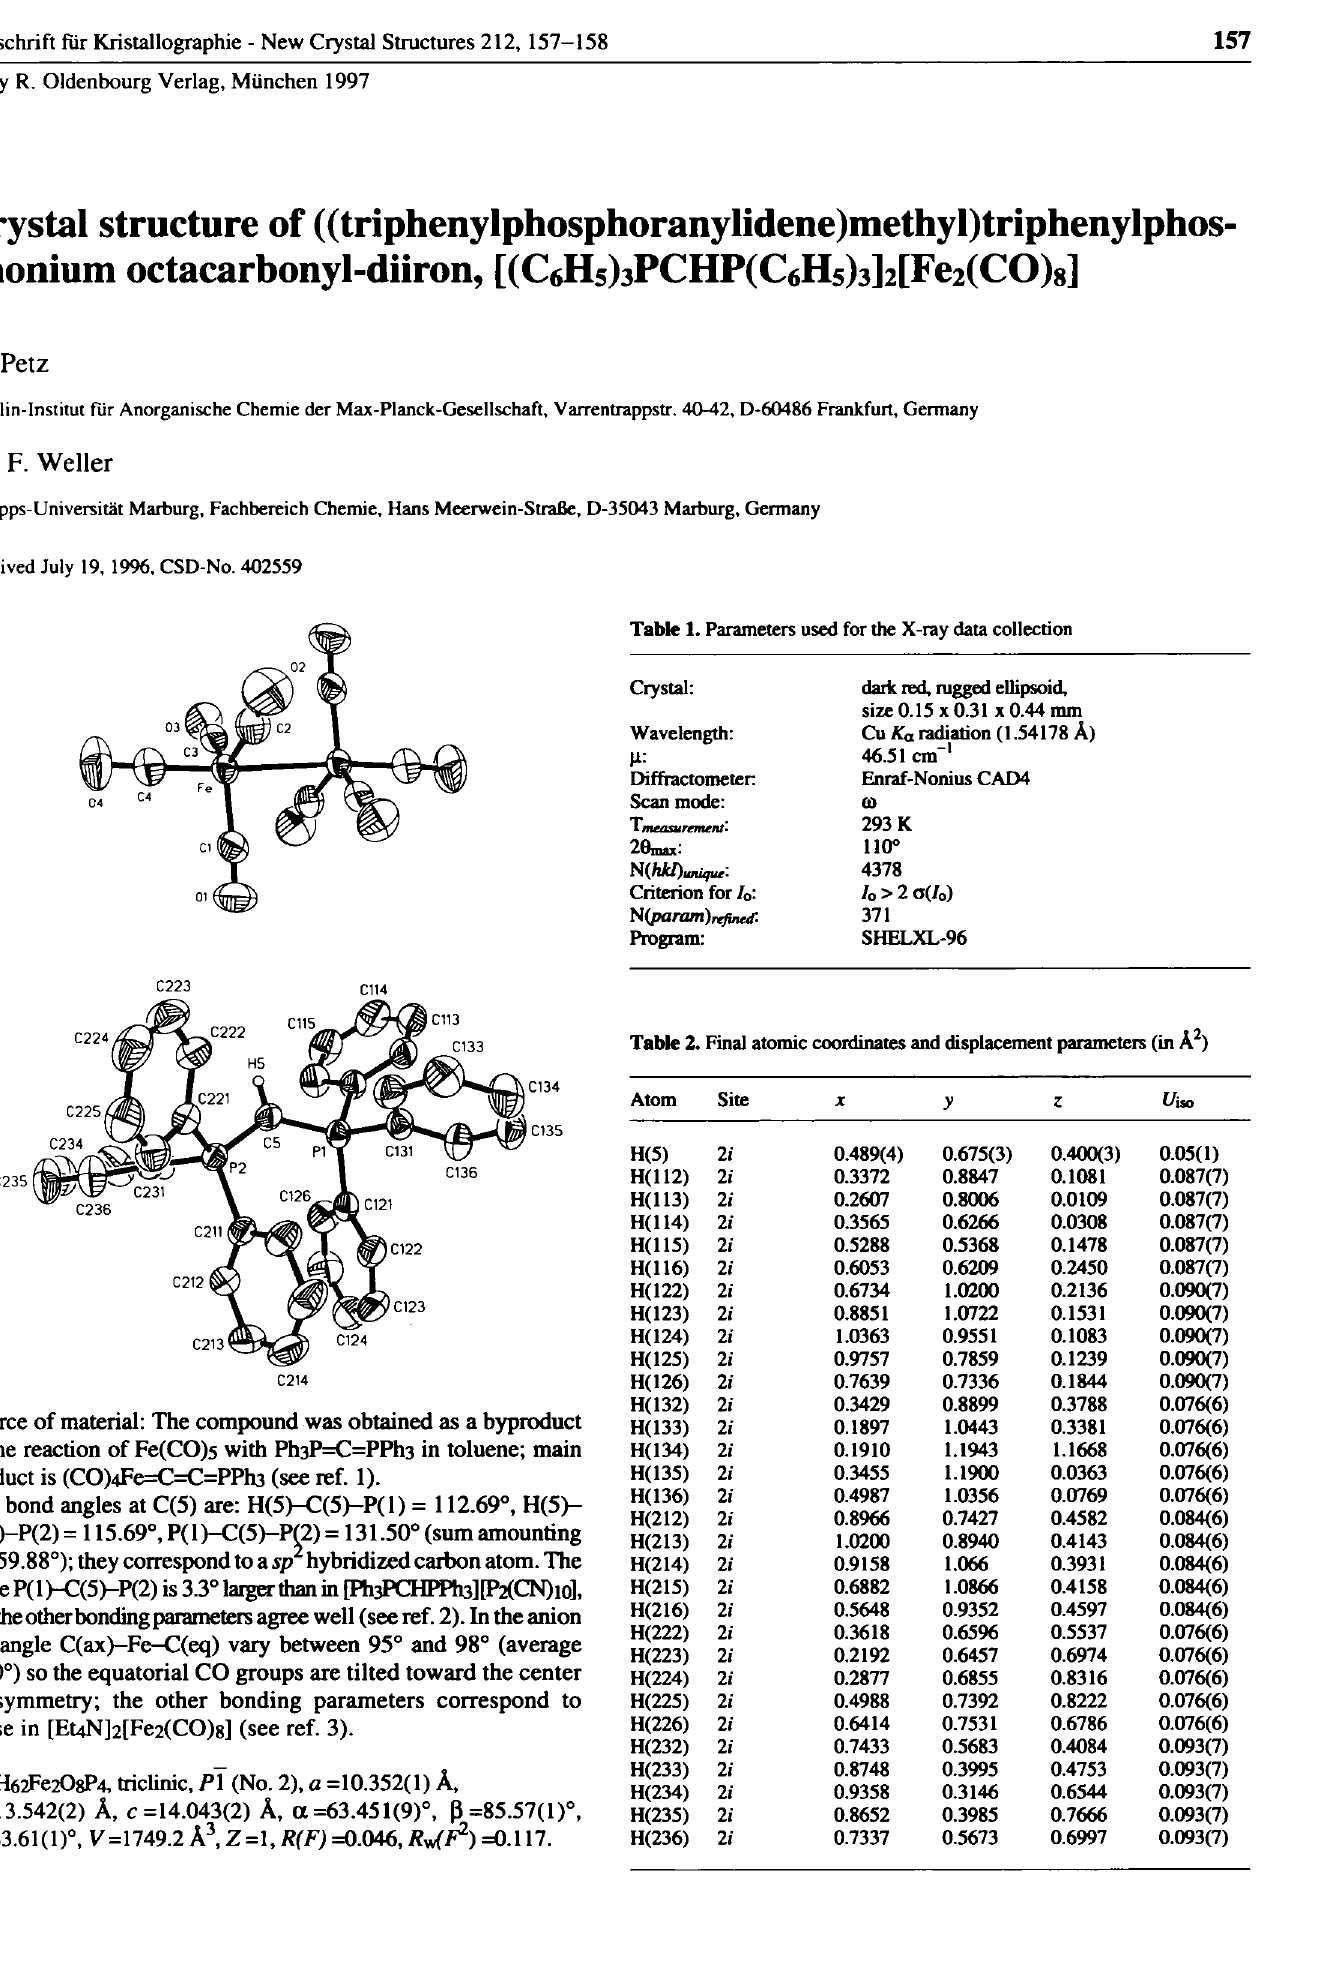
Table 1. Parameters used for the X-ray data collection Crystal: